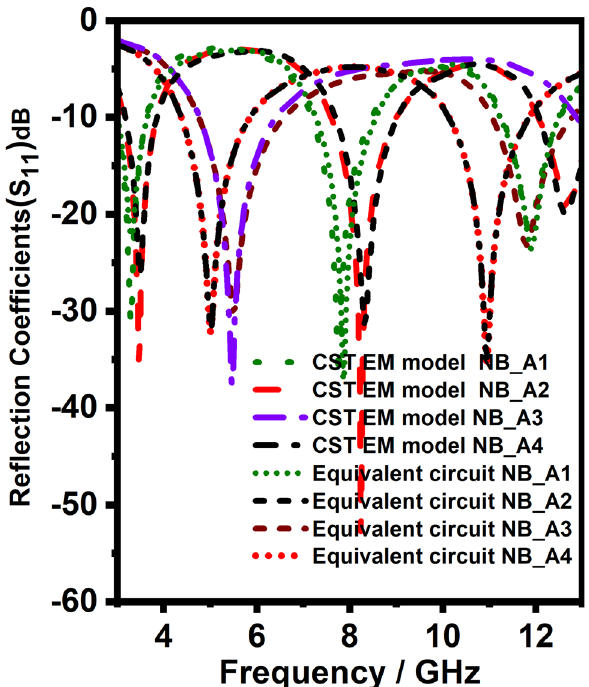
Figure 4. S-parameter comparison between the EM model and the equivalent circuit model for NB antennas.